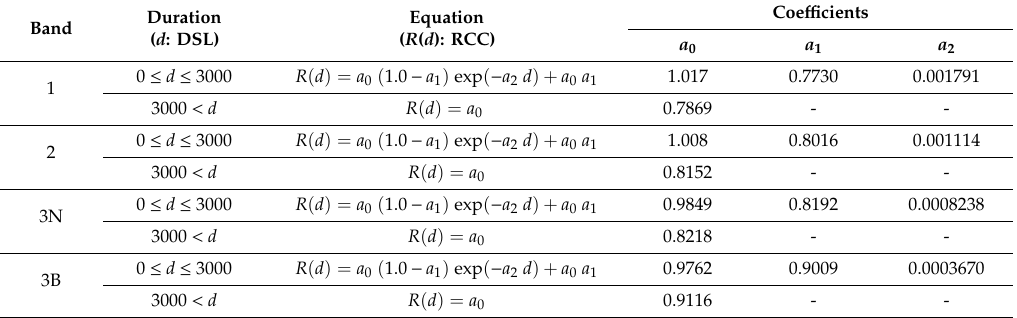
Table 4. The equations and parameters of the new radiometric degradation curves in the radiometric DB ver. 5 for ASTER VNIR